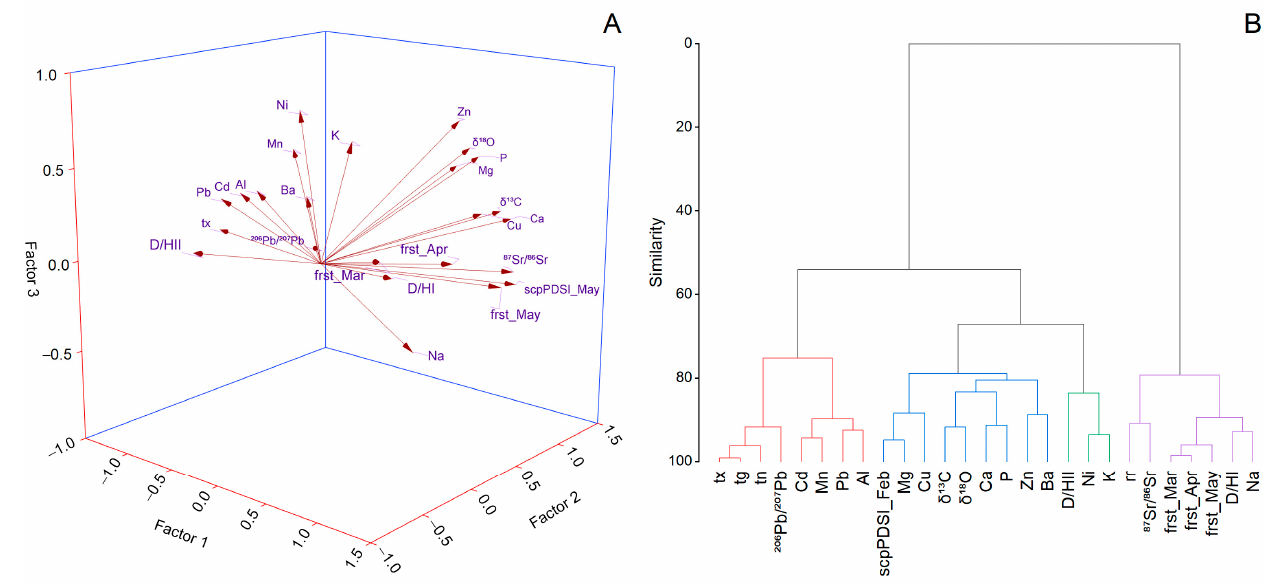
Figure 6. Graphical representation of the fi rst three factors extracted from the factor analysis on the basis of the wine parameters analyzed and environmental variables ( A ). The hierarchical cluster dendrogram resulted from the correlation matrix of the environmental variables and microelements, macroelements, toxic element stable isotopes, and isotope ratio for the Romanian wine analyzed ( B ).